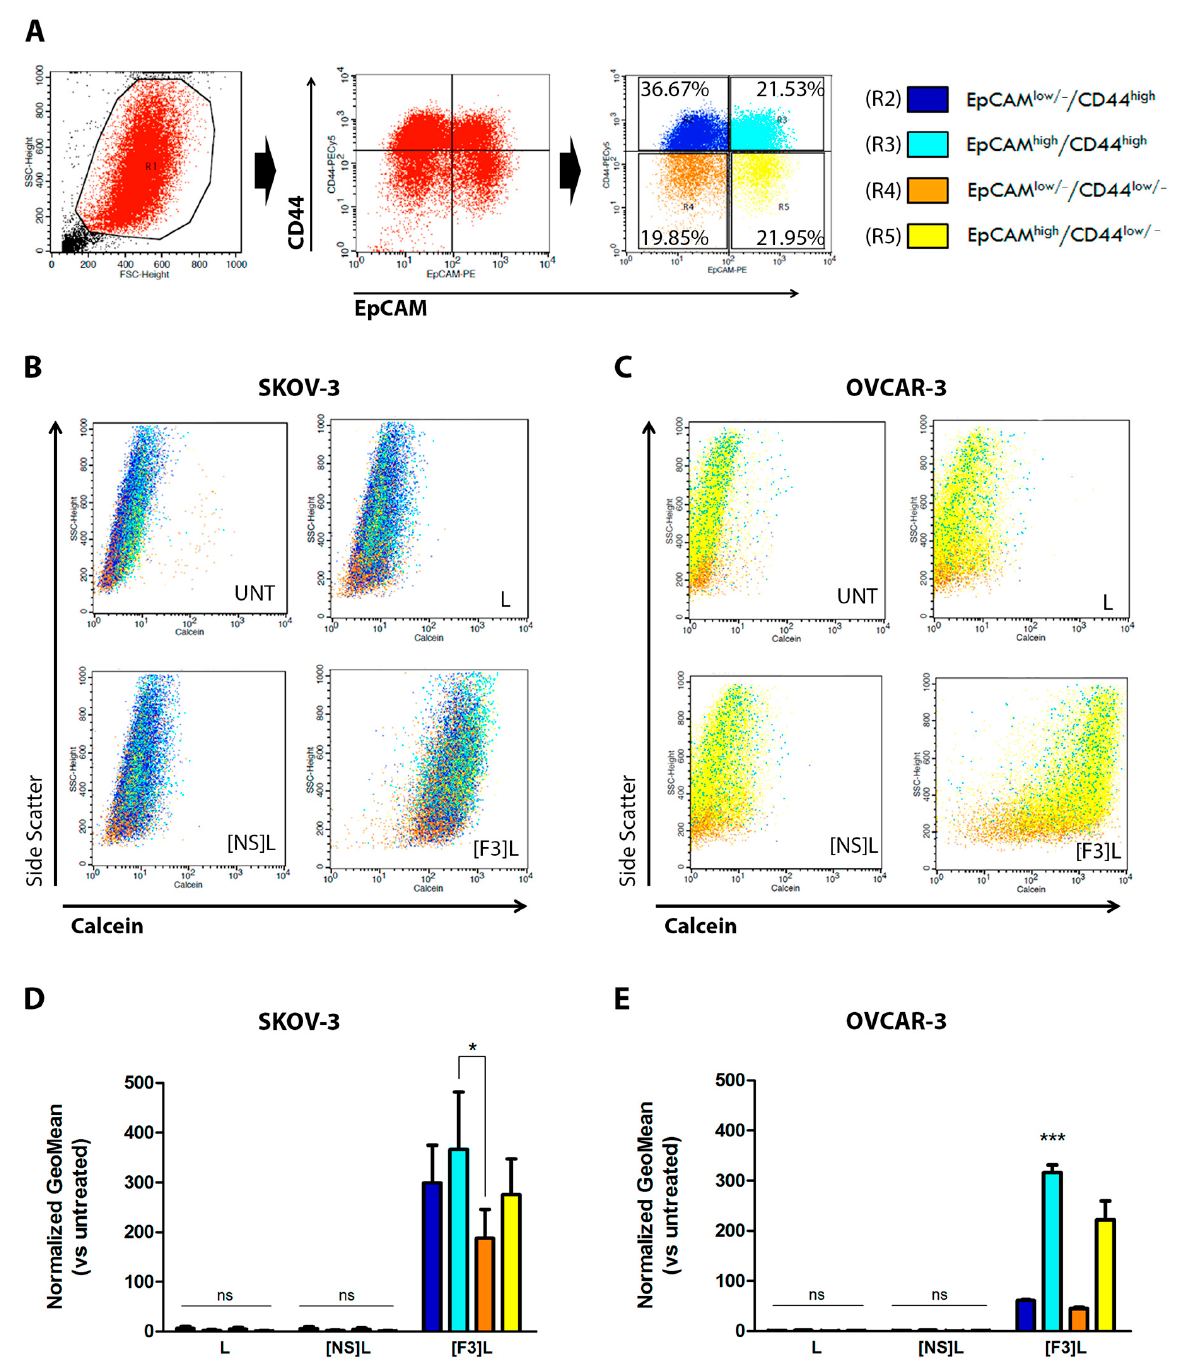
Figure 3. Cellular association of F3 peptide-targeted liposomes with putative ovarian cancer stem cells. ( A ) Flow cytometry gating strategy for the identification of CSC-enriched (R3, light blue) and non-stem cancer cells, -SCC (R4, orange) sub- populations based on the assessment of CD44 and EpCAM surface levels is represented. The calcein/side scatter dot-plots reflecting the calcein signal distribution for ( B ) SKOV-3 and ( C ) OVCAR-3 bulk cells is represented, upon incubation with 0.4 mM (total lipid) of calcein-labeled F3 peptide-targeted ([F3]L), non-specific peptide targeted ([NS]L) or non-targeted (L) liposomes for 4 h at 37 ◦ C. The geometric mean of calcein fluorescence levels for each of the indicated sub-populations for ( D ) SKOV-3 and ( E ) OVCAR-3 cell lines are represented. Data represent the mean ± SEM ( n = 3; two-way ANOVA with Bonferroni’s post-test; ns p > 0.05; * p < 0.05 and *** p <